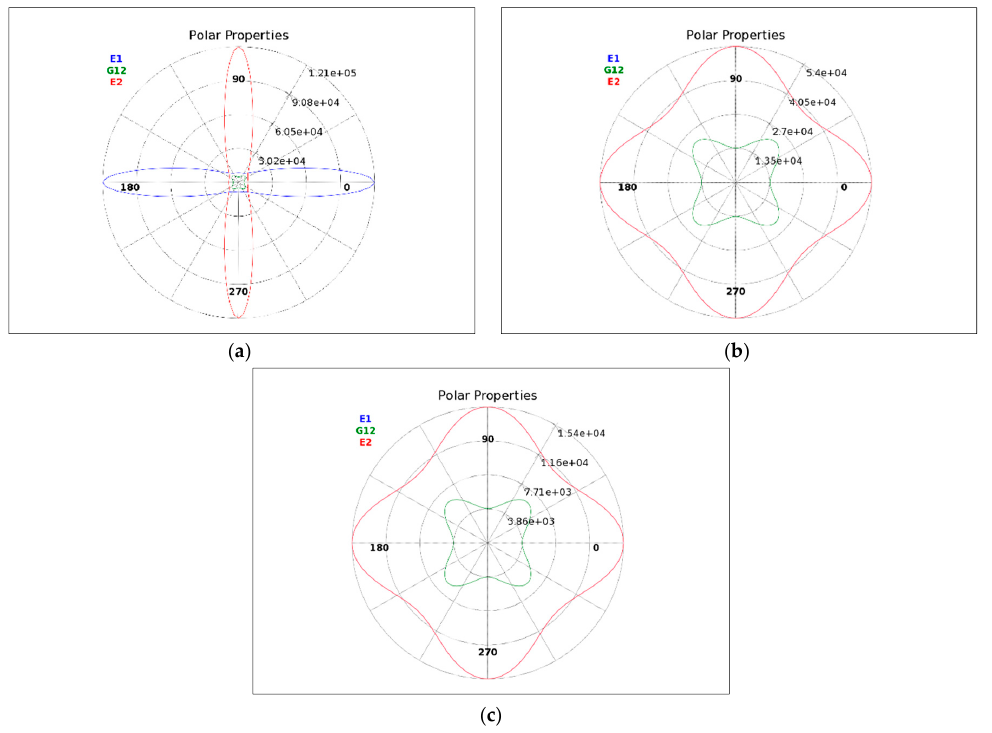
Figure 2. Properties of carbon fibers. ( a ) Epoxy carbon unidirectional (UD) (230 GPa), ( b ) quasi-isotropic laminates without honeycomb (230 GPa), and ( c ) quasi-isotropic laminates with honeycomb (230 GPa ).